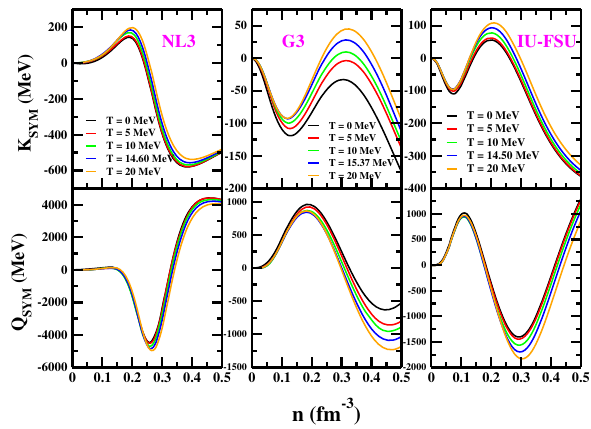
Fig. 4 Symmetry energy ( F sym ) and L sym as a function of nucleon density for SNM ( t = 0). The left panel shows the results for NL3, middle panel for G3 and right panel for IU-FSU parameter set